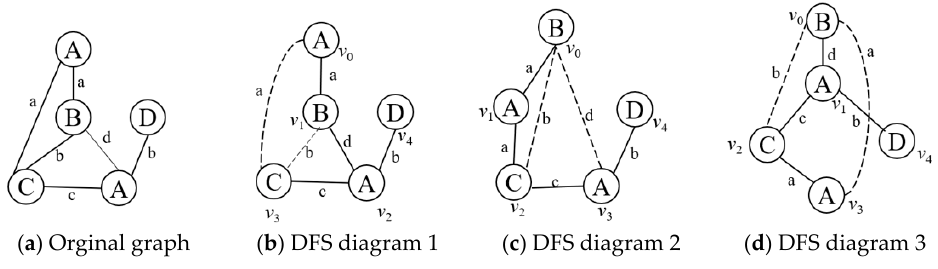
Figure 4. Depth-first search subgraph.